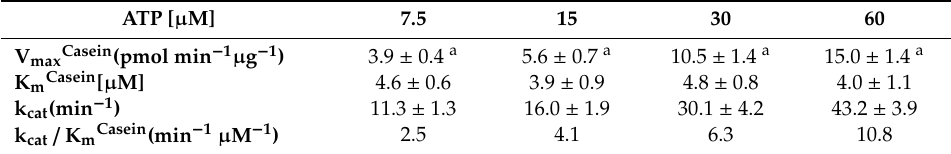
Table 2. Kinetic parameter values of CK1 ε as a function of varying casein concentrations at fixed ATP